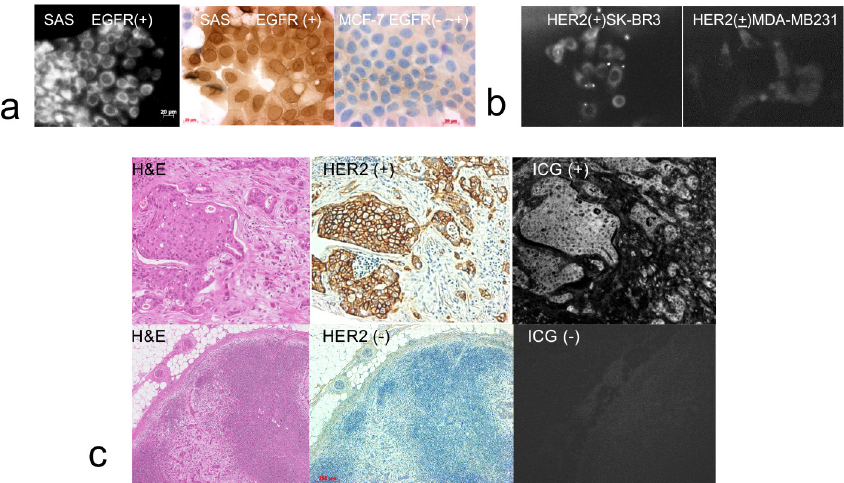
Figure 1. Near-infrared (NIR) imaging of cell lines by the addition of affibody probes to conditioned medium ( a , b ). SAS cells showed strong fluorescence signals of anti-EGFR affibody imaging probes ( a , left). SAS cells ( a , middle) expressed higher anti-epidermal growth factor receptor (EGFR) levels than MCF-7 cells ( a , right). SK-BR3 cells showed stronger fluorescence signals in anti-HER2 affibody imaging probes than MDA-MB231 cells ( b ). Histological section study ( c ). Anti-HER2 affibody probe was administered to histological sections of lymph nodes from breast cancer patients. Metastatic cancer cells are shown after hematoxylin and eosin (H&E) staining ( c , upper row, left). Human epidermal growth factor receptor 2 (HER2) expression was positive in metastatic cancer cells by immunohistochemical staining ( c , upper row, middle). High-intensity NIR signals from the probe identically corresponded with the area of increased HER2 expression ( c , upper row, right). In the HER2-negative metastatic lymph node section ( c , lower row), immunohistochemical staining for HER2 and NIR signals were not visible in metastatic cancer cells ( c , lower row, middle, right). Scale bar in ( a ): 20 µ m. Scale bar in ( c ): 200 µ m.